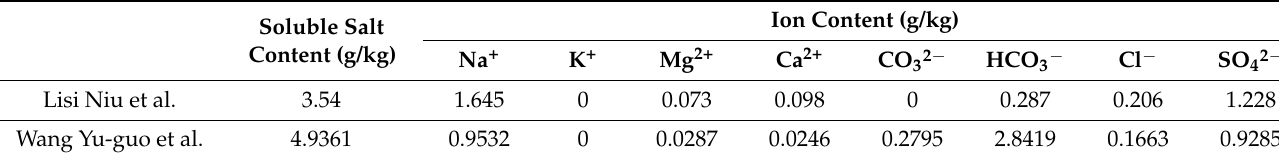
Table 3. Soluble salt content of Yili loess.